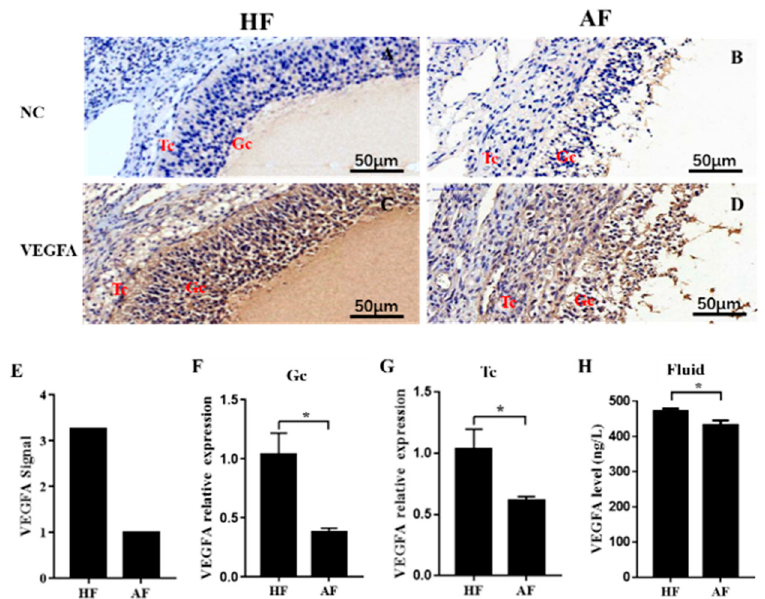
Figure 1. Expression of VEGFA in healthy and atretic antral follicles. ( A – D ): Immunolocalization of VEGFA in healthy ( A , C ) and atretic ( B , D ) antral follicles; € : The signal intensity of VEGFA in follicles detected by the GeneChip Porcine Genome Array; ( F , G ): relative expression levels of VEGFA in GC and TC, respectively, detected by qRT-PCR; ( H ): expression level of VEGFA in the follicle fluid detected by ELISA. NC, negative control; HF, healthy follicle; AF, atretic follicle; GC, granulosa cell; Tc, theca cell; scale bar = 50 µm. Data are expressed as the mean ± SEM. * p < 0.05.